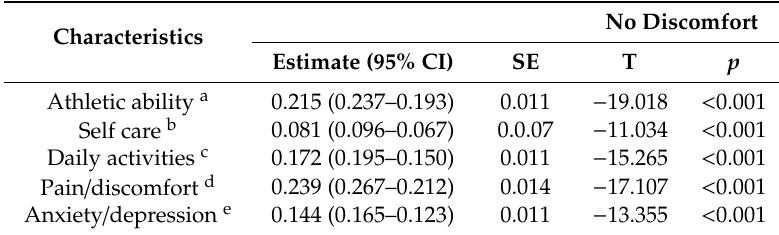
Table 4. Impact of masticatory discomfort on quality of life